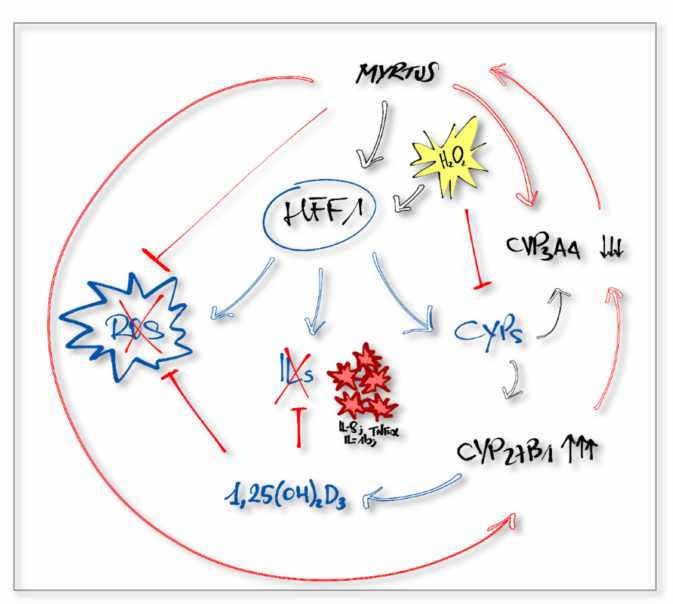
Figure 6. Regulatory activity of Myrtus products. Myrtus extracts exert antioxidant